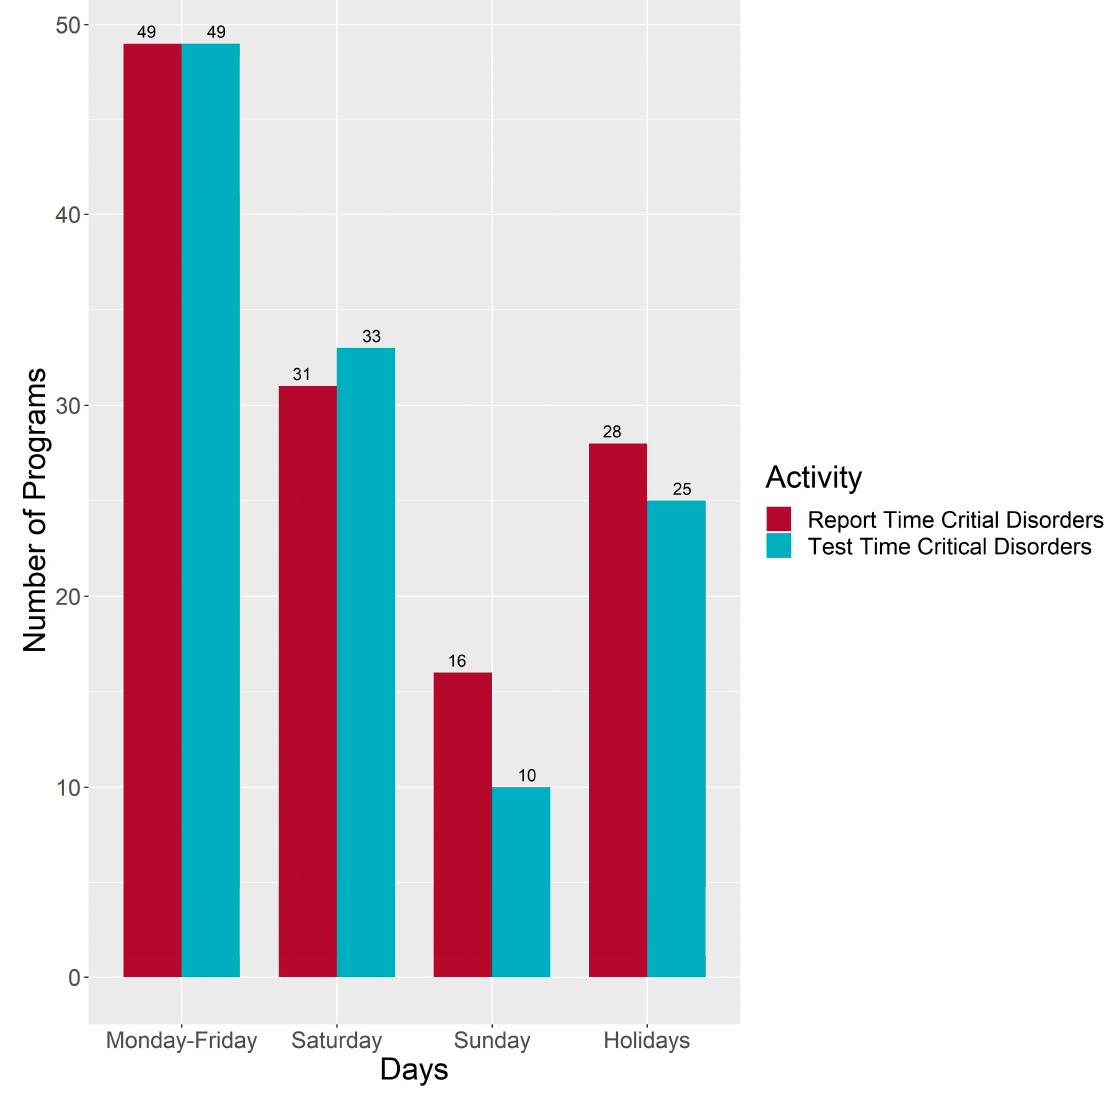
Figure 2. Days newborn screening (NBS) laboratories test for time-critical disorders and days NBS o ff er follow-up reports on time-critical disorders ( N =